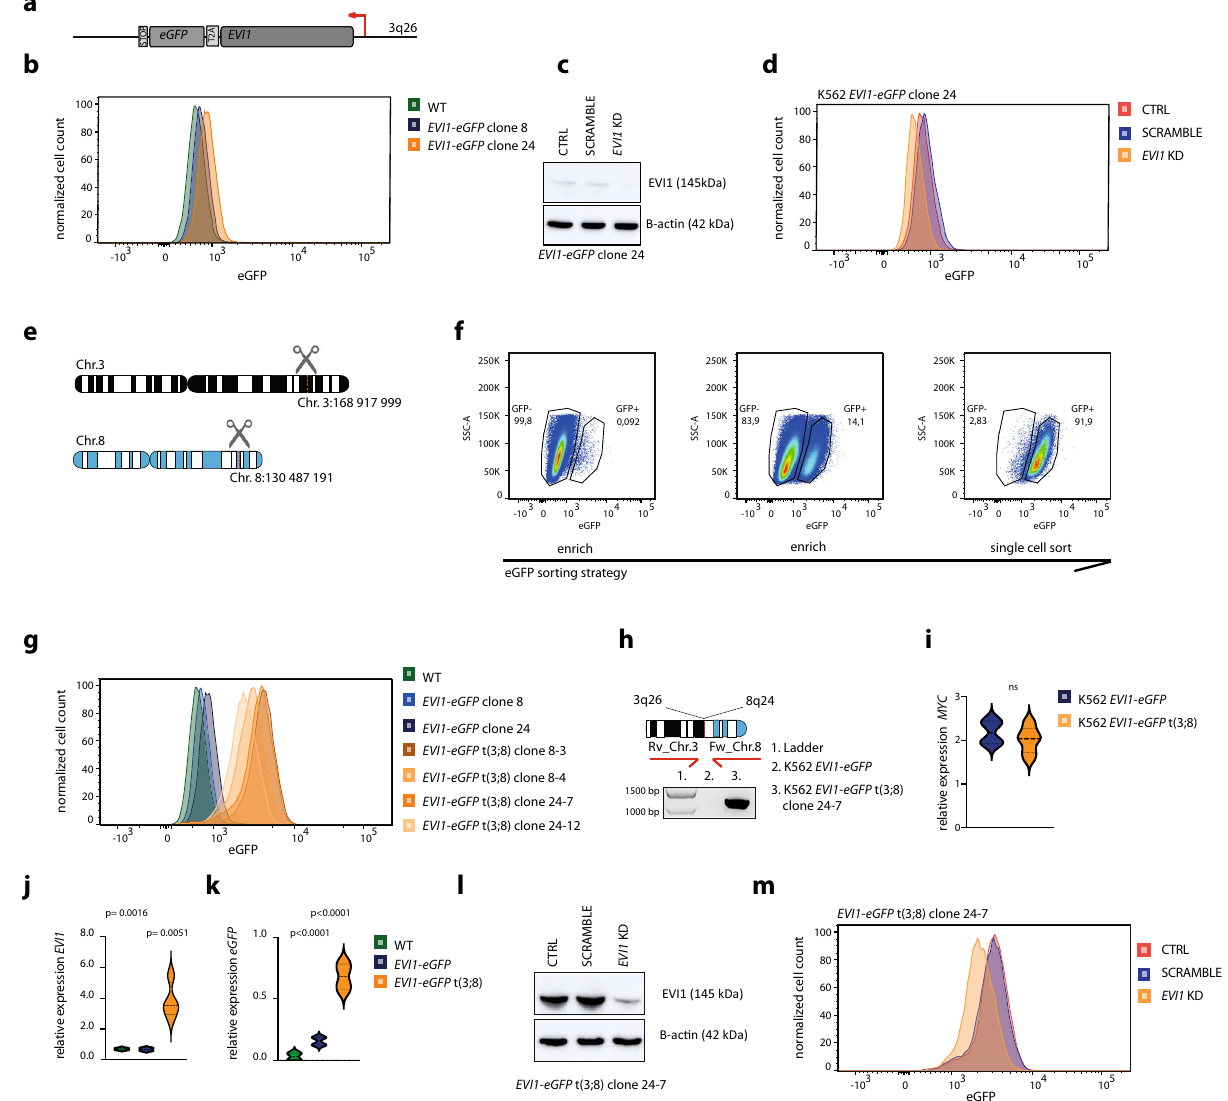
4C-seq taking the EVI1 promoter as a viewpoint revealed that the strong interaction with the MYC SE was severely diminished in the eGFP negative fraction upon deletion of module C (Fig. 4g). This loss of chromosomal interaction was also observed taking the MYC SE as a viewpoint (Fig.